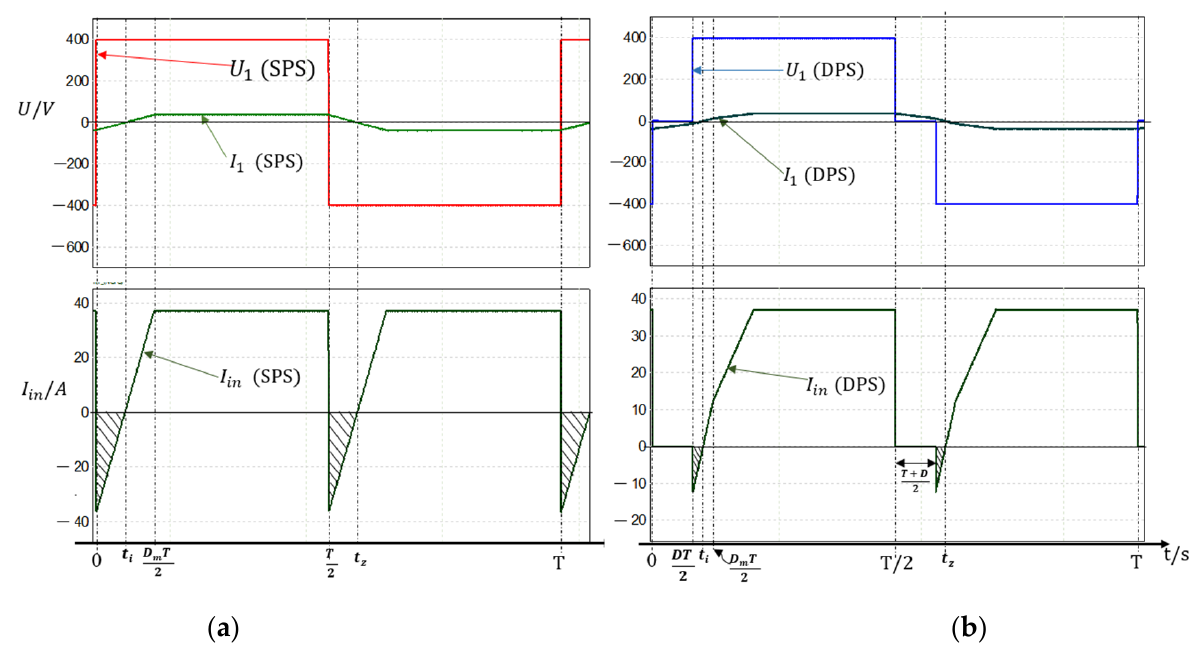
Figure 10. Backflow power in the TAB converter ( a ) SPS control ( b ) DPS control.